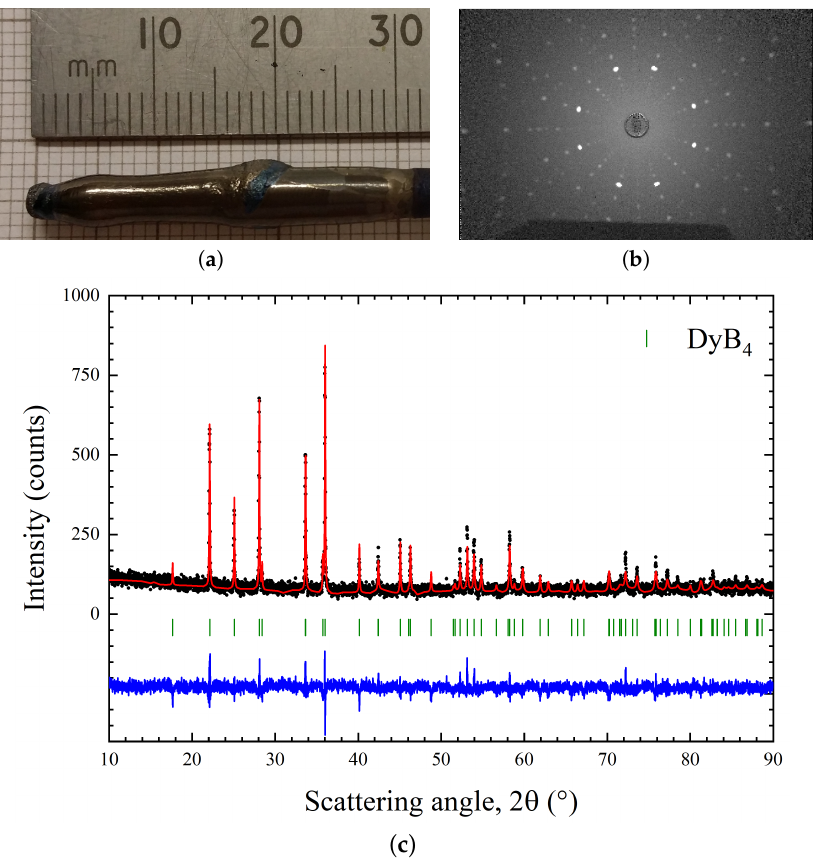
Figure 6. ( a ) Boule of DyB 4 prepared by the floating-zone method in an argon atmosphere at a growth rate of 18 mm/h. ( b ) X-ray Laue back reflection photograph of a crystal of DyB 4 , showing the [001] orientation of an aligned sample used for physical properties measurements. ( c ) Room temperature powder X-ray diffraction pattern of a ground DyB 4 crystal. The experimental profile (black closed circles) and a full profile matching refinement (red solid line) made using the P 4/ mbm tetragonal structure are shown, with the difference given by the blue solid